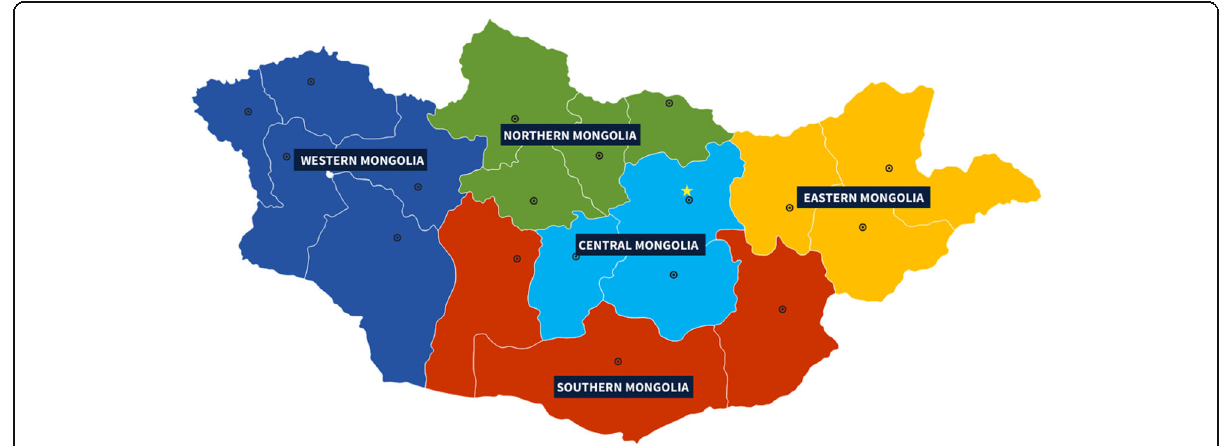
Fig. 1 Mongolia ’ s regions (Ulaanbaatar, in Central region, marked by